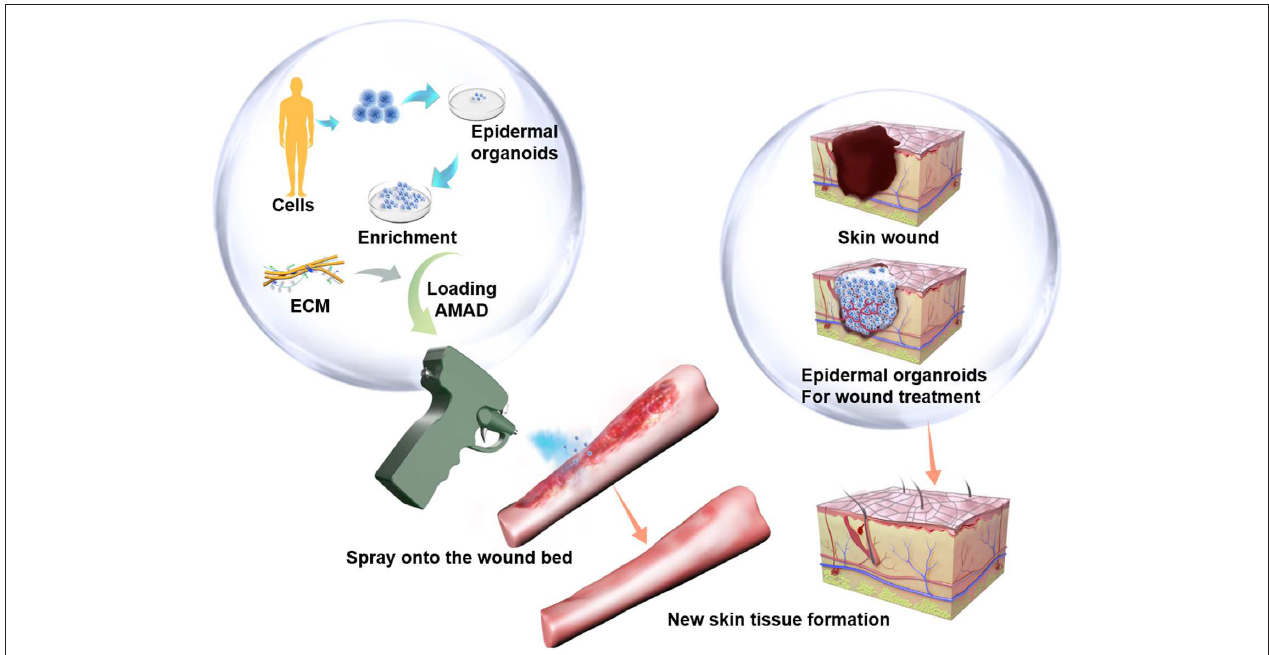
FIGURE 1 | The potenial therapeutical application of the cell-delivery system for treatment of large and irregular wounds in clinic by an AMAD. In this study, primary human skin epidermal organoids were sprayed and delivered onto the wound. They effectively accelerated skin wound healing through participation in epidermis